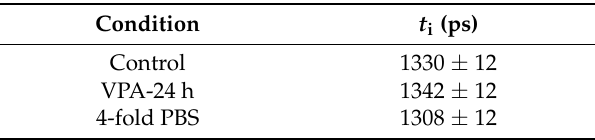
Table 1. Chromatin compaction modulation measured by